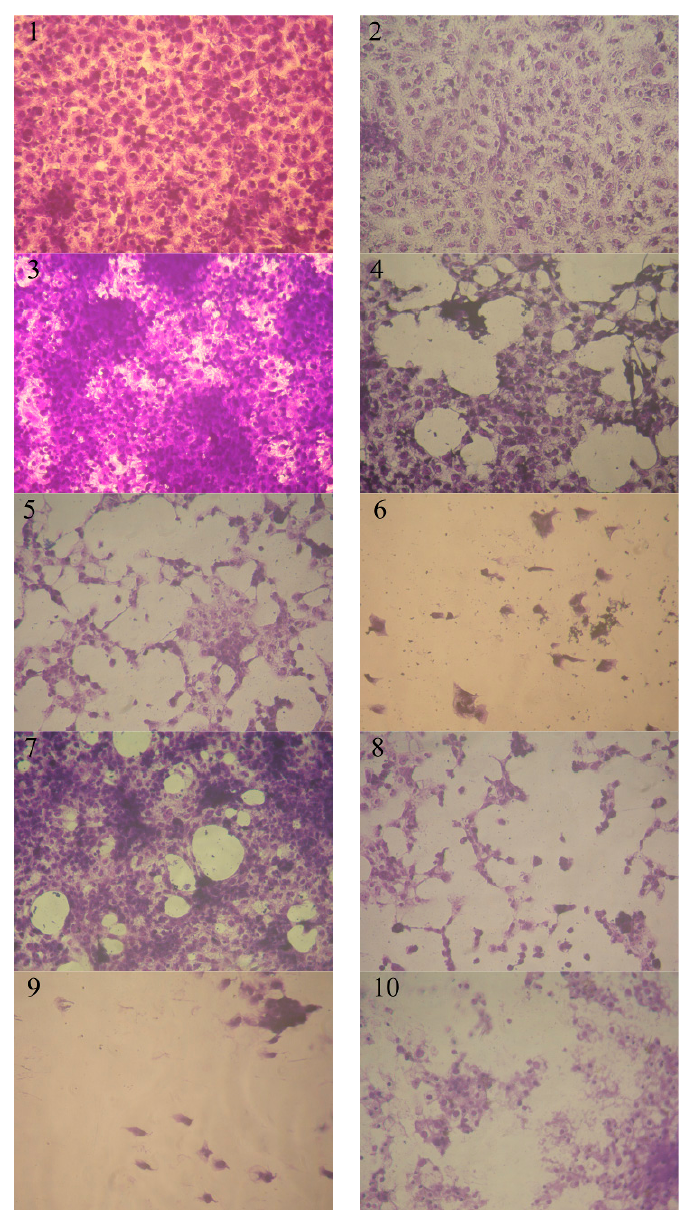
Figure 1. E ff ect of various concentrations of tested compounds on HepG-2 cell inhibition activity. (1) Control HepG-2 (2) compound 6 (7.8 µ g / mL), (3) compound 14 (7.8 µ g / mL), (4) compound 14 (125 µ g / mL), (5) compound 6 (125 µ g / mL), (6) compound 6 (500 µ g / mL), (7) compound 12 (7.8 µ g / mL), (8) compound 12 ( 125 µ g / mL), (9) compound 16 (500 µ g / mL), and (10) compound 14 (500 µ g /